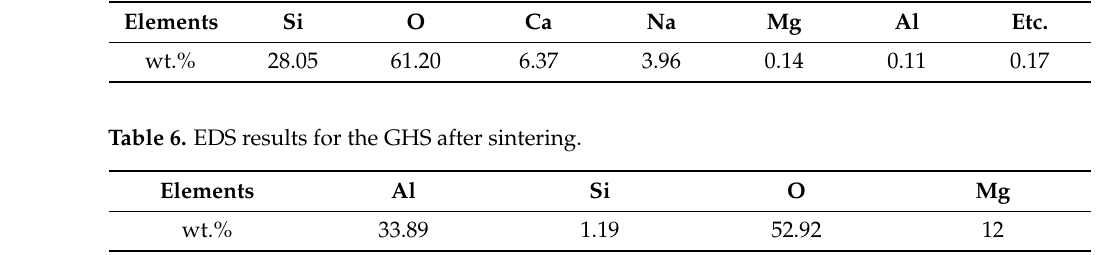
Table 5. EDS results for GHS before sintering.